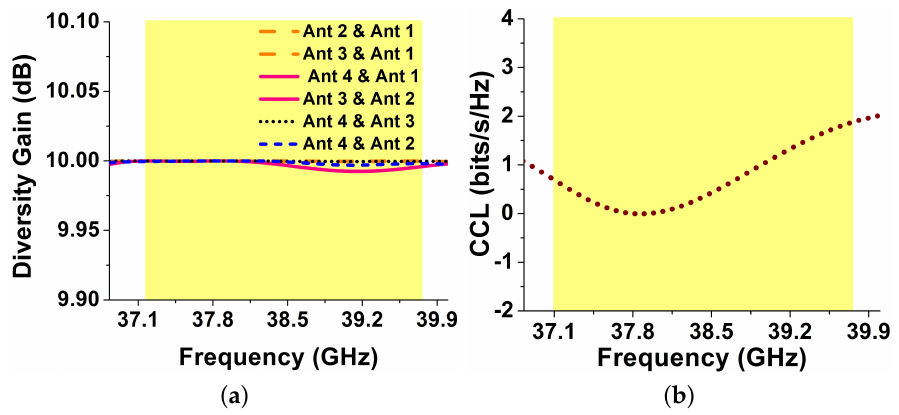
Figure 12. ( a ) DG; ( b ) CCL, for the proposed 5G MIMO